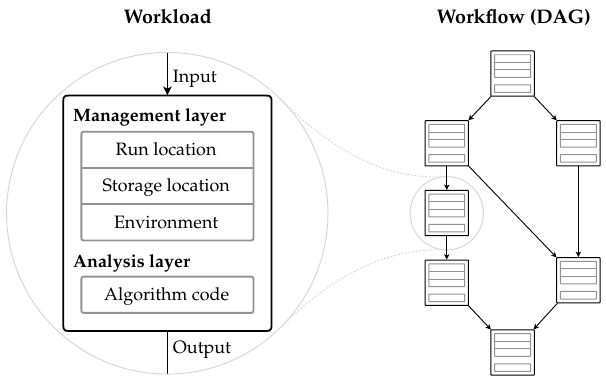
Figure 5.1: Illustration of a workflow composed of multiple workloads. Workloads consist of Figure 1: Illustration of a workflow composed of multiple workloads, forming a directed a management layer that defines and handles run location, storage location, and environment, and an analysis layer comprising the actual algorithm code to run. The analysis layer is fully de- acyclic graph (DAG). The management layer defines and handles run location, storage loca- coupledfromthemanagementlayer, allowingforinterchangeabilityofresources. Dependencies tion, and environment. The analysis layer comprises the actual algorithm to run and is fully between workloads (arrows) result in a directed acyclic graph (DAG). decoupled from the management layer, allowing for interchangeability of